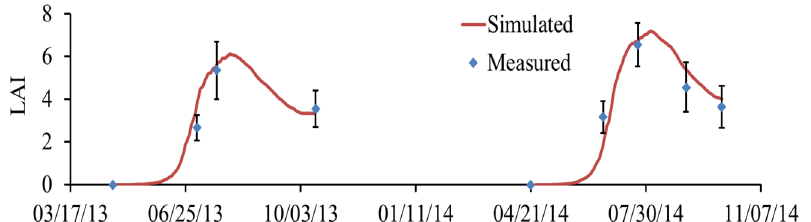
Figure 3. Comparison of measured and simulated leaf area index (LAI) under N312 treatment in loamy clay soil.